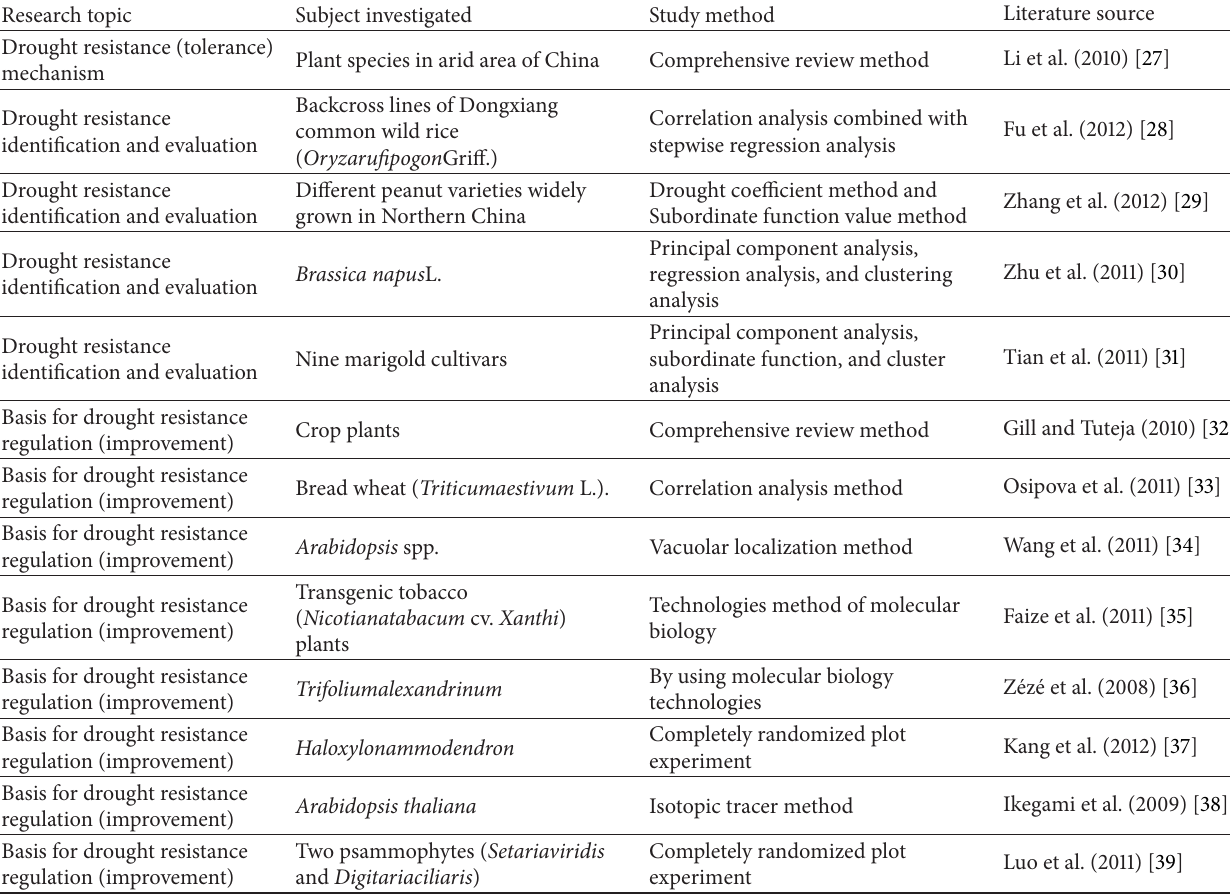
Table 2: Typical cases of study on potential of water saving and drought-resistance of plant